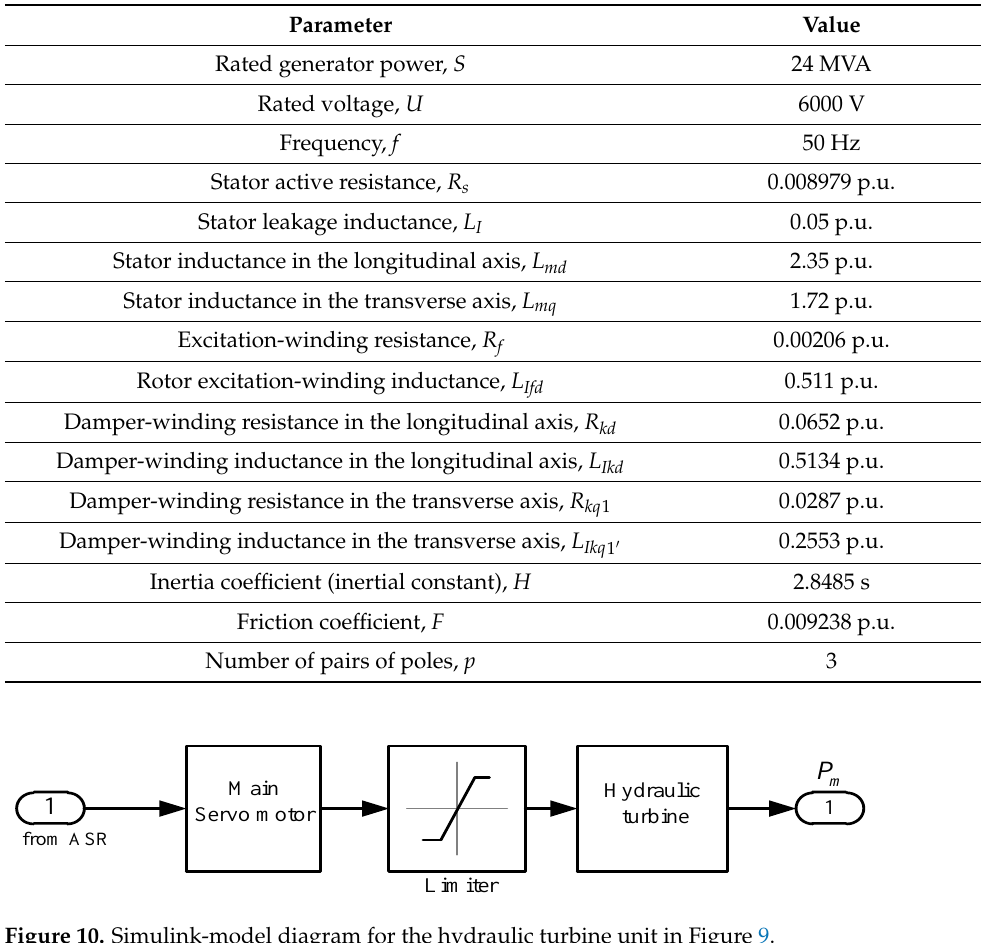
The model diagram (Figure 9) also shows the measurement points of the experimental